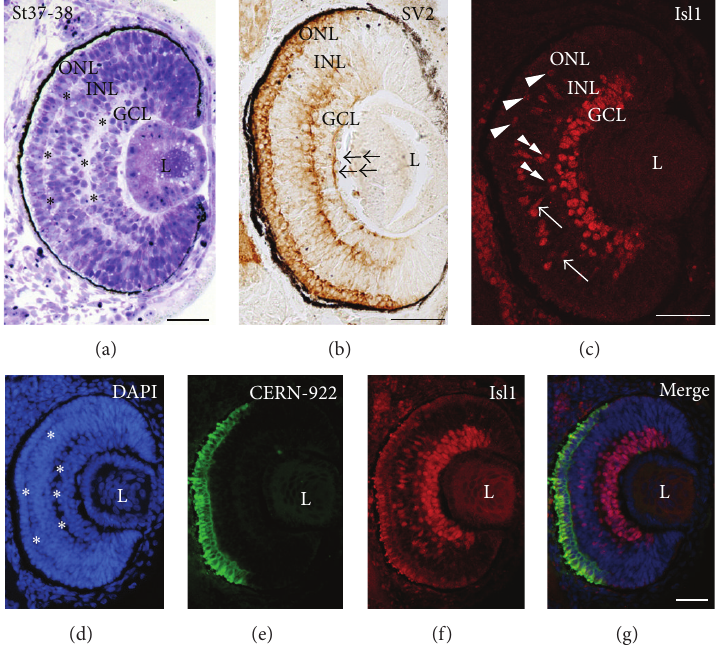
Figure 5: Morphological features and expression patterns of Isl1 and other cell differentiation markers in the St37/38 Xenopus laevis retina. (a) Toluidine blue-stained transverse retinal resin sections showed that the plexiform layers were observed across the central to mid-peripheral extent of the retina (asterisks). An immature GCL, 2-3 cells in depth, was also observed at this stage. (b) SV2 immunoproducts were observed in the OFL (double arrows), IPL, and ONL. (c) Abundant nuclei were immunoreactive for Isl1 in the GCL, but also in the INL. Thus, nuclei located in the amacrine cell layer (double arrowheads), bipolar cell layer (arrows), and horizontal cell layer (arrowheads) were detected with this antibody. (d)–(g) Incipient plexiform layers were also clearly distinguishable with the DAPI nucleic acid stain (asterisks in (d)). CERN- 922 immunoreactivity paralleled the expression of Isl1 and extended towards the more mid-peripheral region of the retina. GCL: ganglion cell layer; INL: inner nuclear layer; L: lens; ONL: outer nuclear layer. Scale bars: 50 𝜇